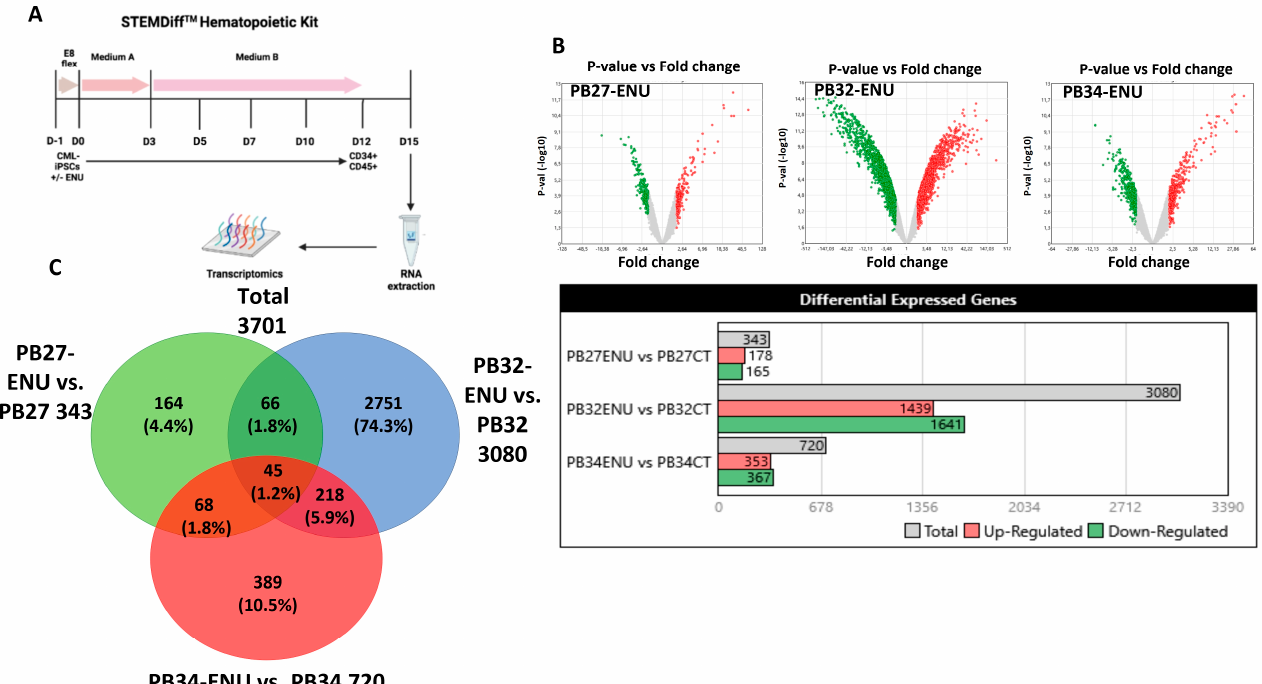
Figure 5. Transcriptomic profile comparison between three mutated CML-iPSCs and their normal counterparts after hematopoietic differentiation. ( A ) Hematopoietic differentiation protocol. Tran- scriptomic analysis was performed at D15 of differentiation. ( B ) Differential expression analysis (DEG) between ENU and control condition of each CML-iPSCs. ( C ) Venn diagram comparing the 3 DEG.